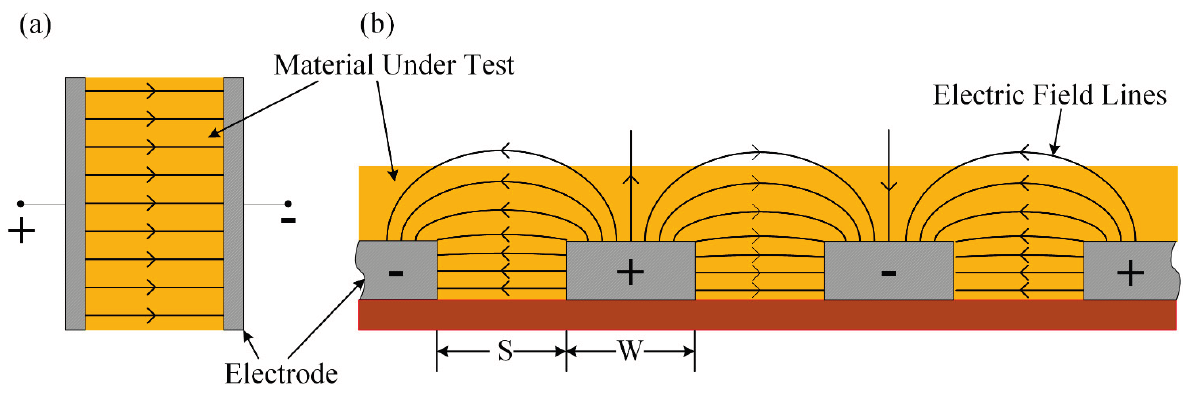
Figure 1. Electric fields of the ( a ) parallel plate capacitor and ( b ) coplanar interdigital